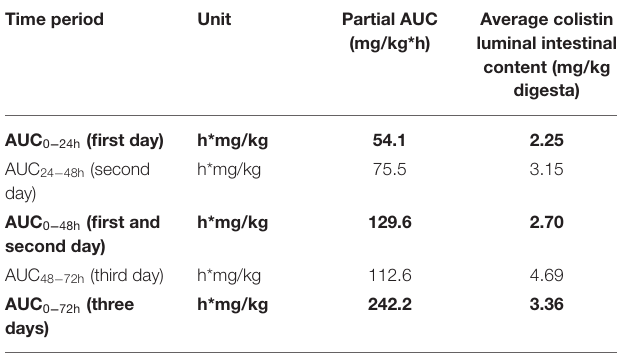
TABLE 2 | Partial AUC calculations and average colistin intestinal content (or average colistin content in the digestive tract) after administration of a nominal dose of 75,000 IU/kg/day of colistin